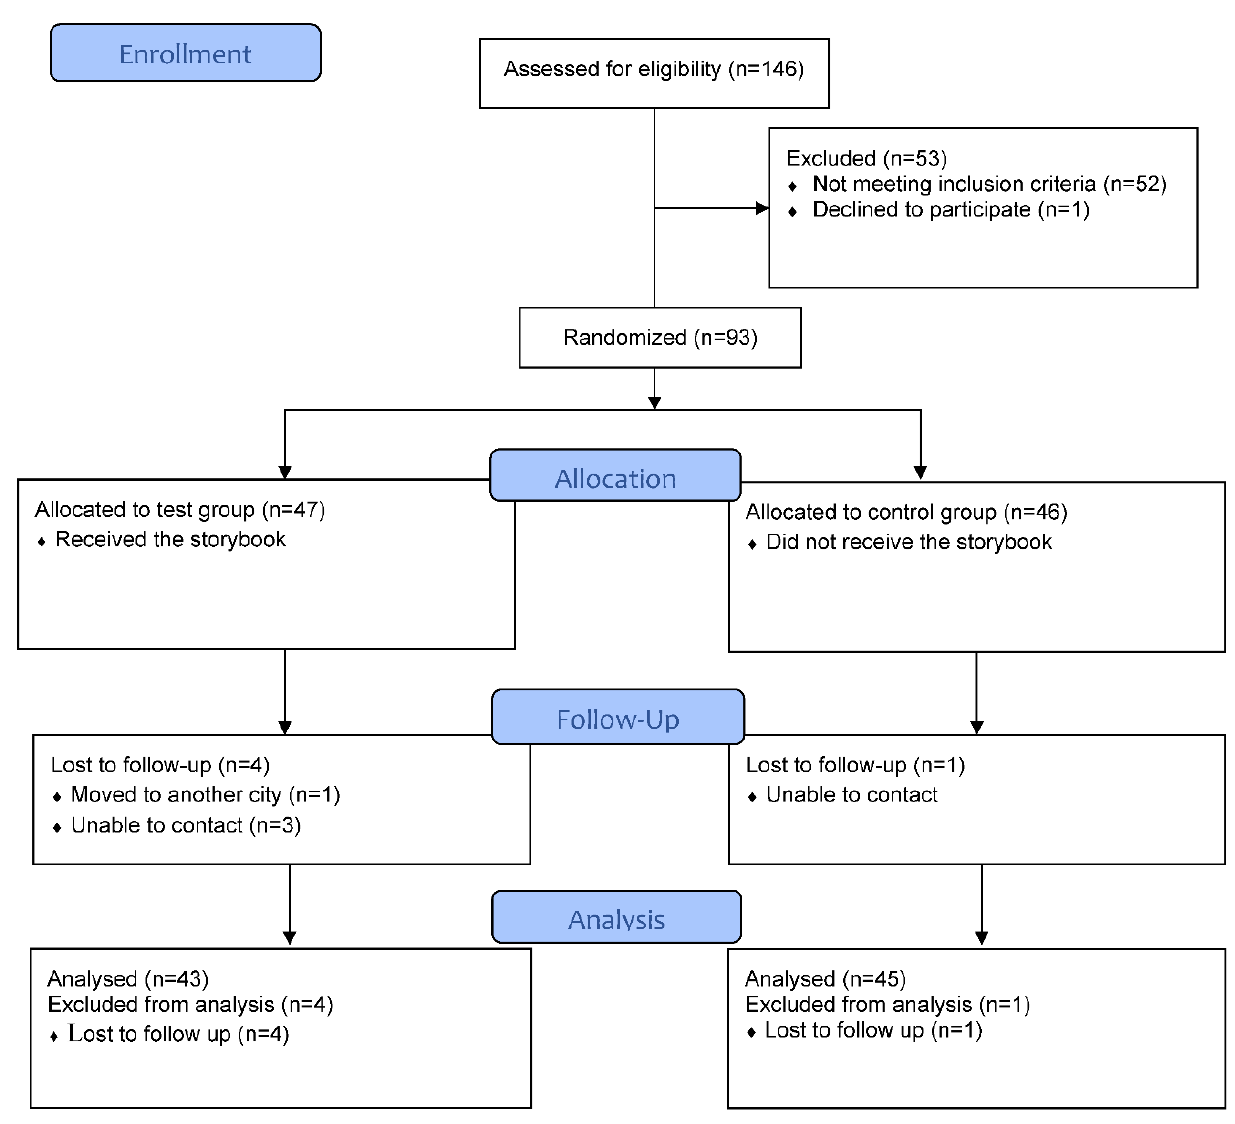
Figure 2. CONSORT flow diagram: the flow of patients during each trial phase.